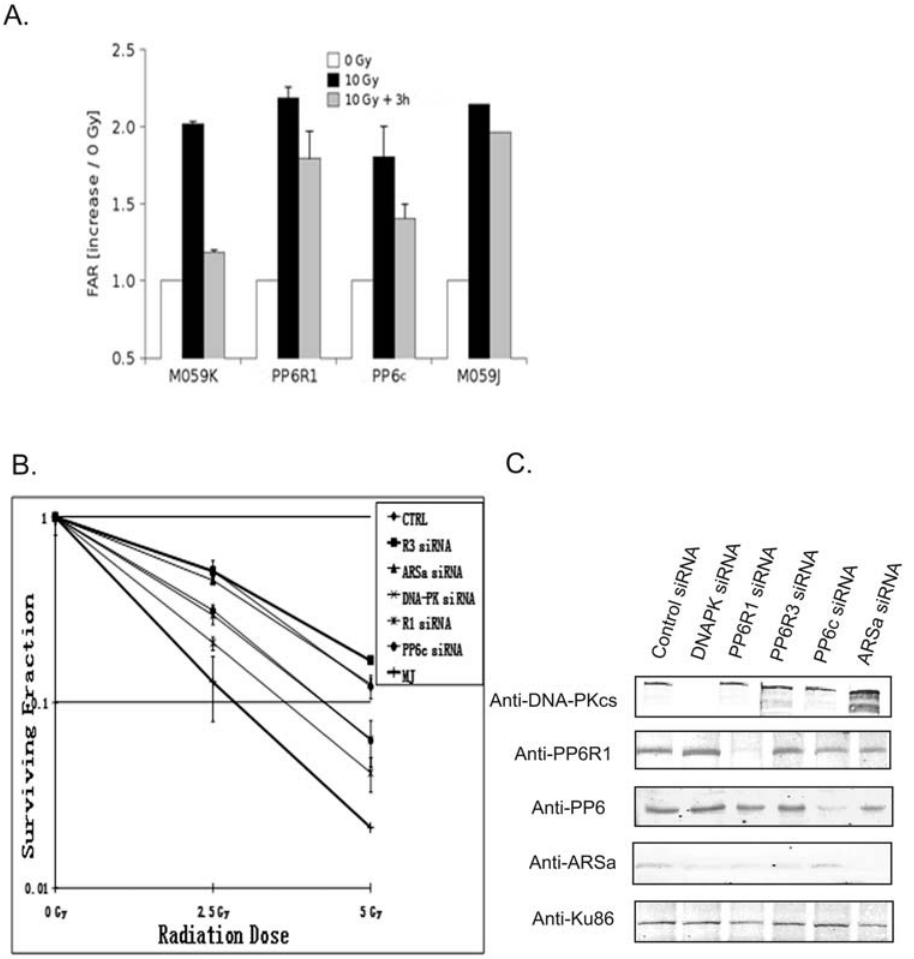
Figure 5. siRNA knockdown of PP6R1 or PP6c decreases repair of DNA double-strand breaks and sensitizes glioblastoma cells to radiation. A. Two days after transfection with siRNA cells were irradiated with 10 Gy and either harvested immediately (10 Gy) or allowed to repair DNA damage for 3 hours (10 Gy + 3 hours) prior to harvesting cells. Harvested cells were embedded in agarose plugs and subjected to PFGE as described. The bars represent the fraction of DNA released from agarose plugs during PFGE, normalized to sham-irradiated control ( 6 SEM). The data are from two independent experiments. M059J cells were used as a negative control. B. M059K cells were transfected with control siRNA or specific siRNAs targeted to DNA-PKcs, PP6R1, PP6c, PP6R3, or ARS-A. Two days after transfection, the M059K cells were irradiated with 0, 2.5, 5 Gy, replated, cultured for two weeks and scored for surviving colonies. The data points show the mean of surviving fraction 6 SD (n=3). M059J cells were used as a negative control. C. Representative Western blot for siRNA knockdown efficiency. The blot shows the level of the proteins of interest after transfection with siRNA. Ku86 is a marker for the nuclear fraction and was used as a loading control.